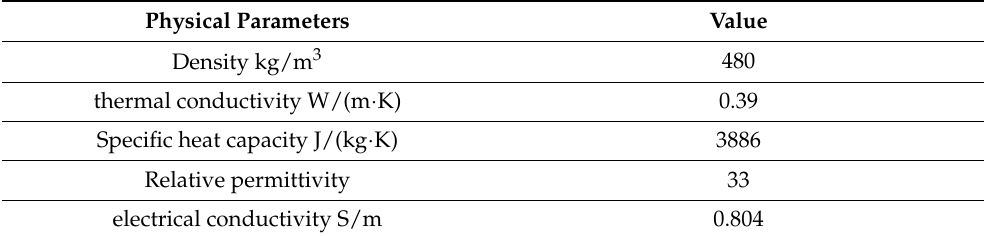
Table 3. Physical parameters of lung tissue in deflated group.